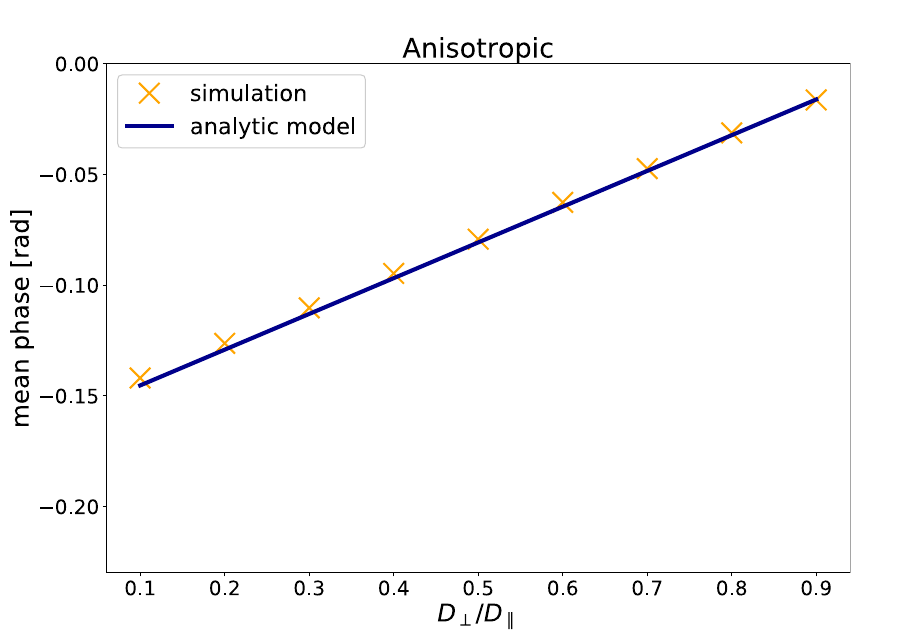
Fig 4. The results of the validation simulation A3: The mean net phase versus D ? / D k for 3D diffusion.